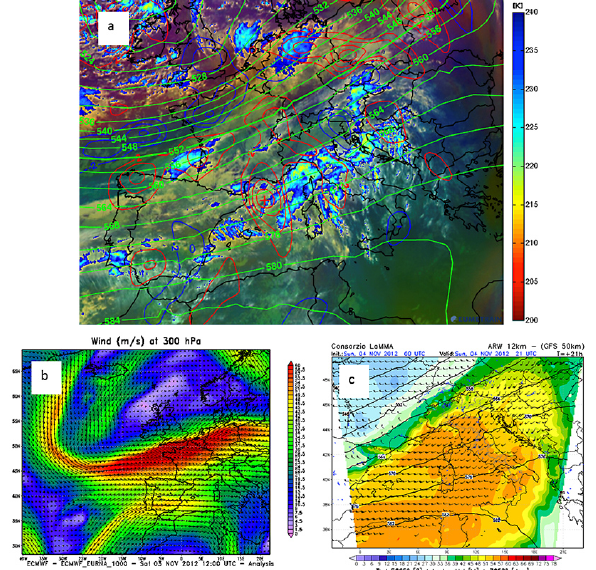
Figure 18. (a) As in Fig. 2 but at 12:00UTC, 3 November 2012. Source: http://www.eumetrain.org. (b) Wind speed at 300hPa: ECMWF analysis, 4 November 2012 at 12:00UTC; (c) equiva- lent potential temperature and low-level jet at 850hPa, geopotential height at 500hPa from WRF-ARW LaMMA.